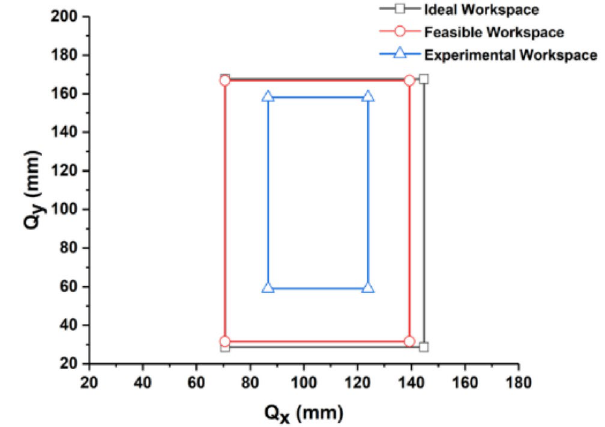
Fig. 16 Workspace area of C5 manipulator